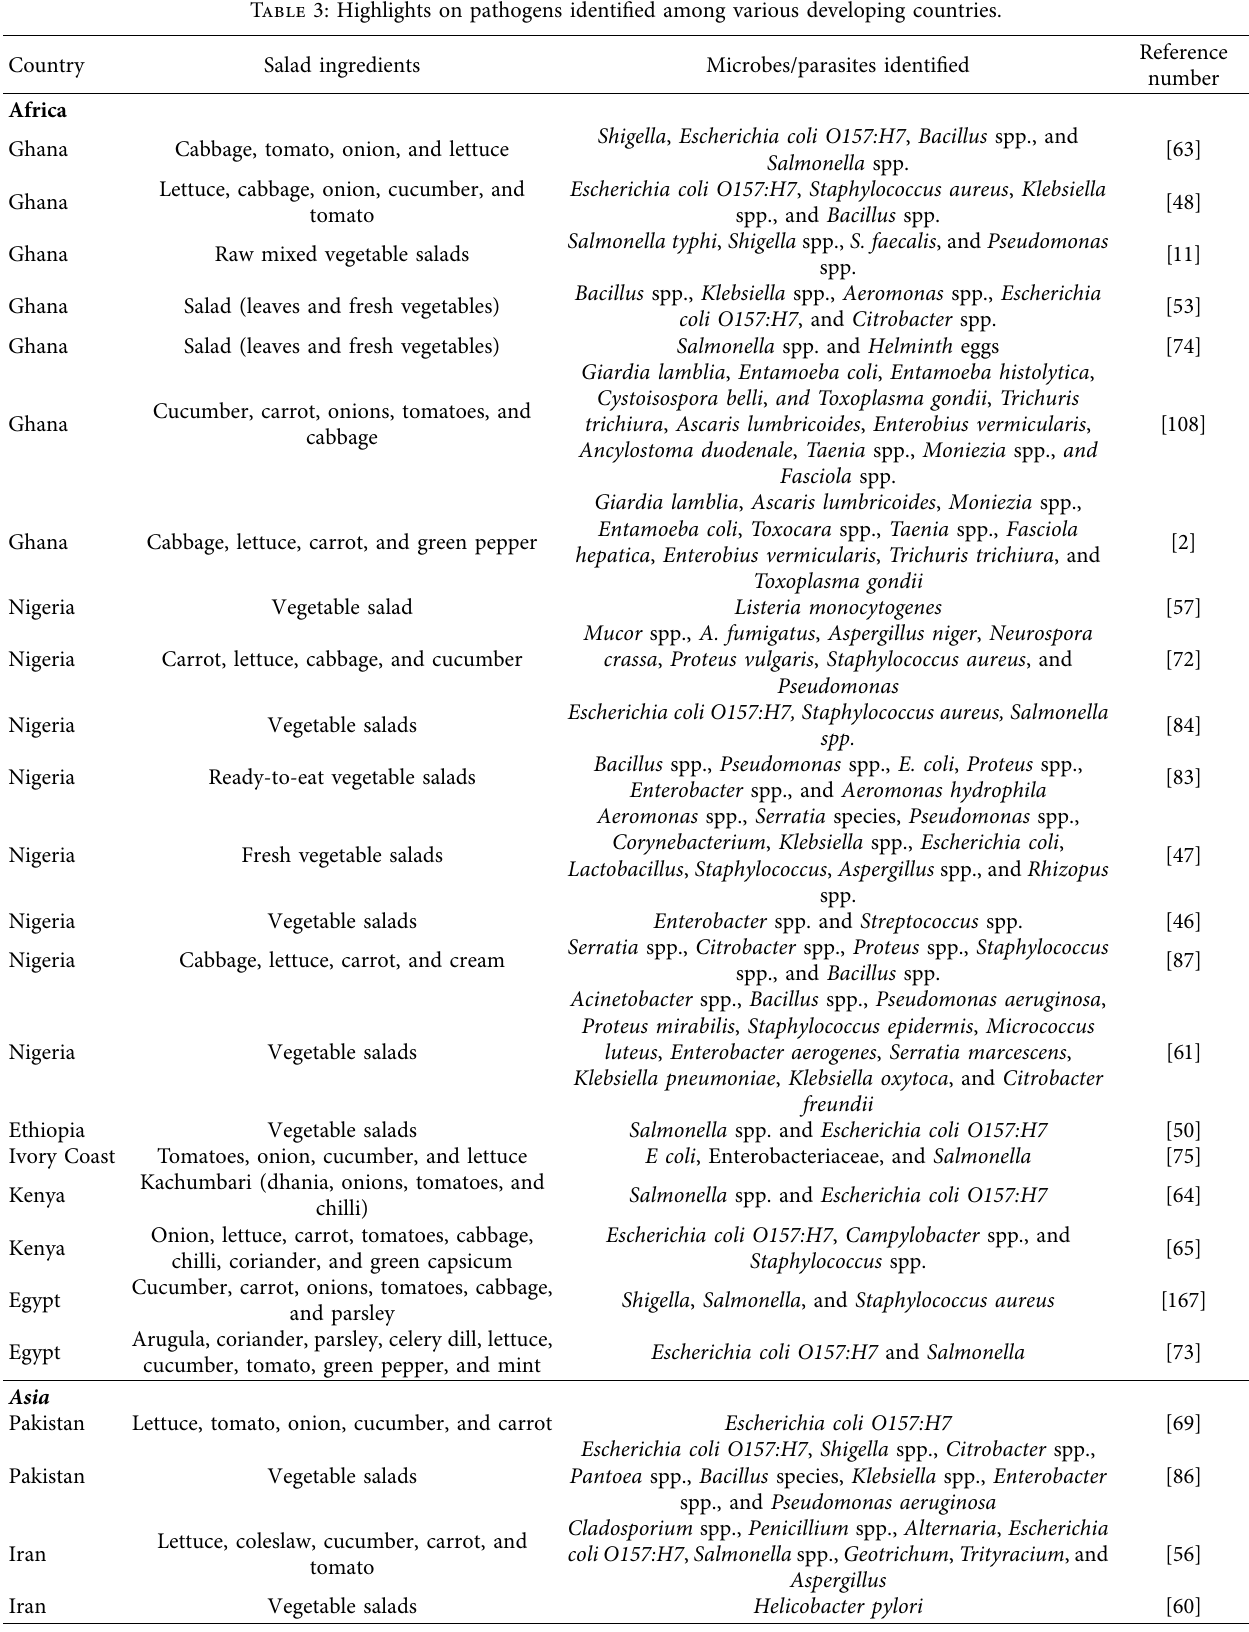
Table 3: Highlights on pathogens identified among various developing